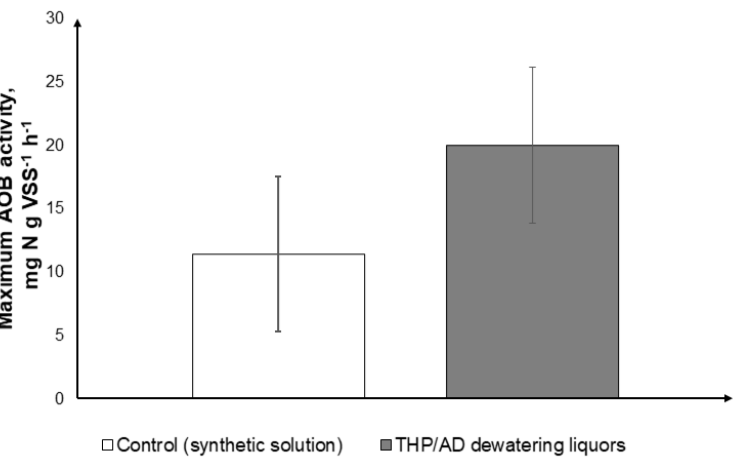
Figure 3. Maximum ammonia oxidizing bacteria (AOB) activity with thermal hydrolysis dewatering anaerobic digestion liquors and synthetic feed solution for control.